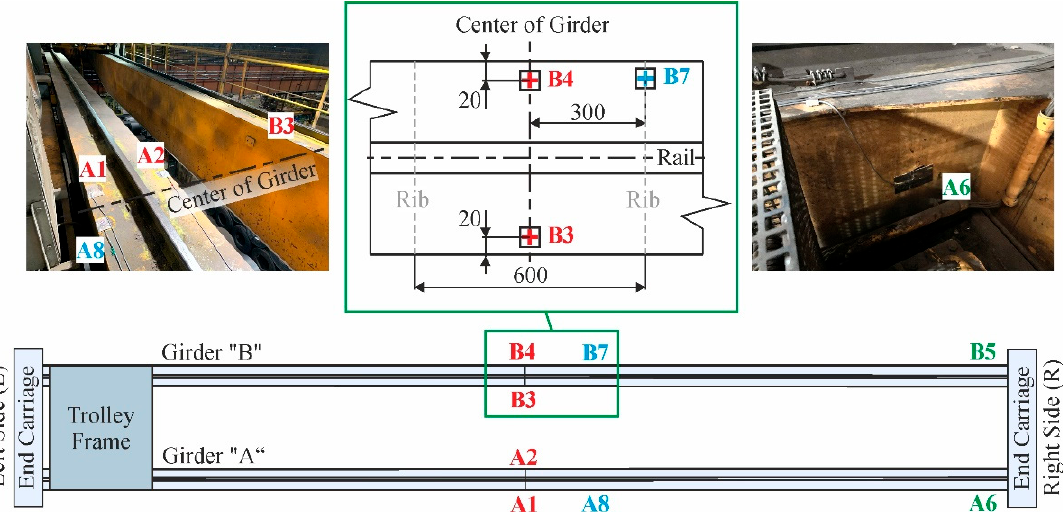
Figure 1. Schematic view of strain gauge locations.